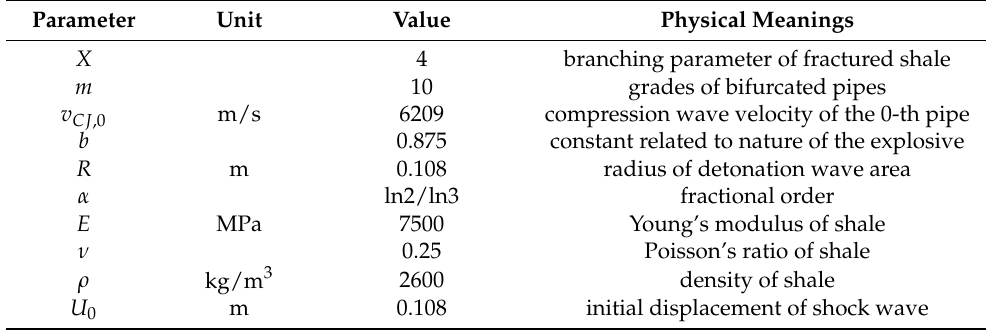
Table 1. Model parameters in computation of analytical model.